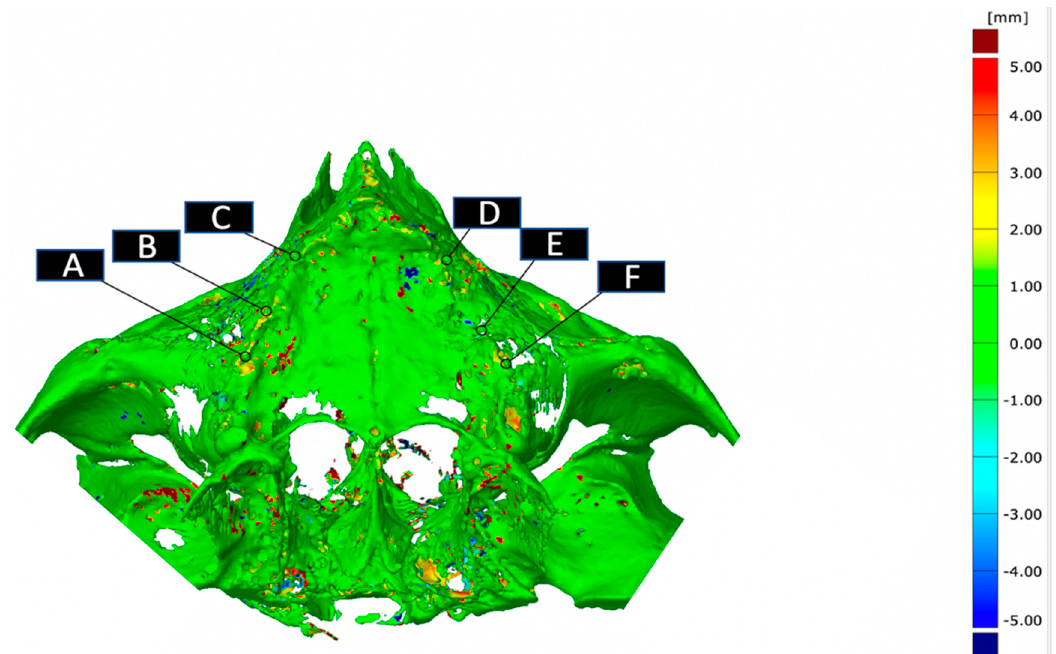
Figure 2. Bony surface reference points in the axis of the post. A–F indicates the reference points under the posts.